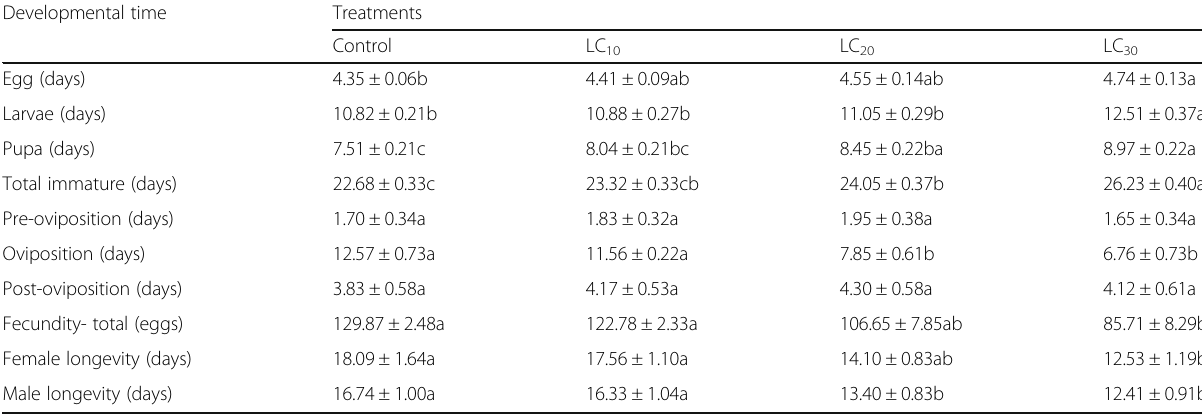
Table 2 Life history parameters (mean ± SE) of Tuta absoluta treated with different sub-lethal concentrations of Metarhizium anisopliae (DEMI 001